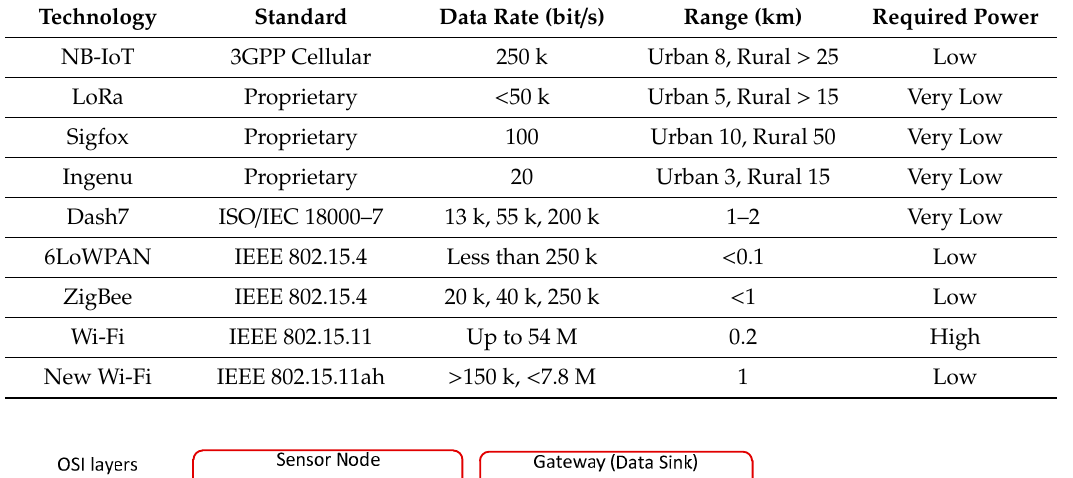
Table 2. Low-Power Wireless Area Network technologies basic features. LoRa: Long-range.